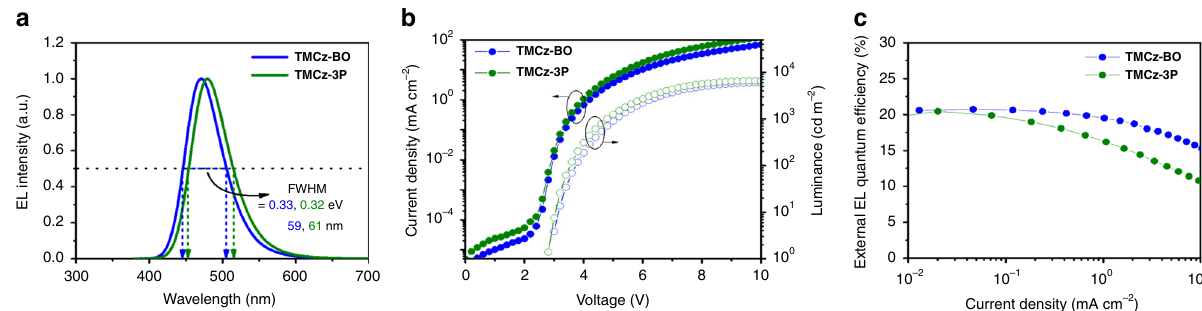
Fig. 6 OLED characteristics. a Normalized EL spectra, b current density – voltage – luminance ( J – V – L ) characteristics, and c external EL quantum ef fi ciency ( η ext ) versus luminance plots of TMCz-BO- and TMCz-3P -based